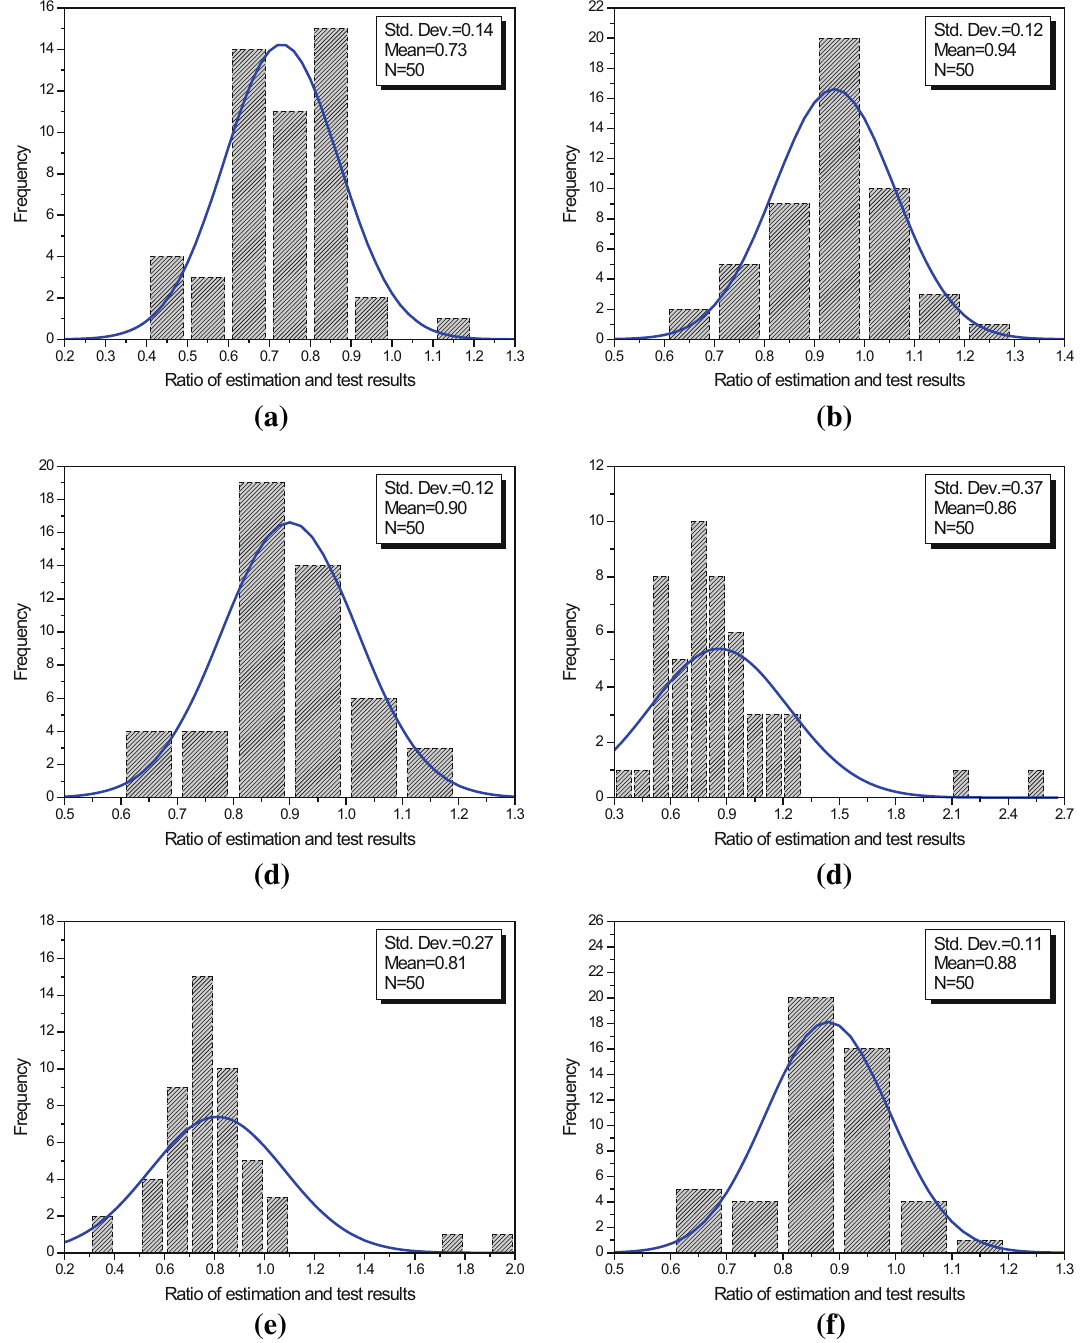
Fig. 6 Histograms and normal distribution curves: a ASCE equation, b Kanno equation, c M-Kanno equation, d AIJ equation, e M- AIJ equation, and f our proposed